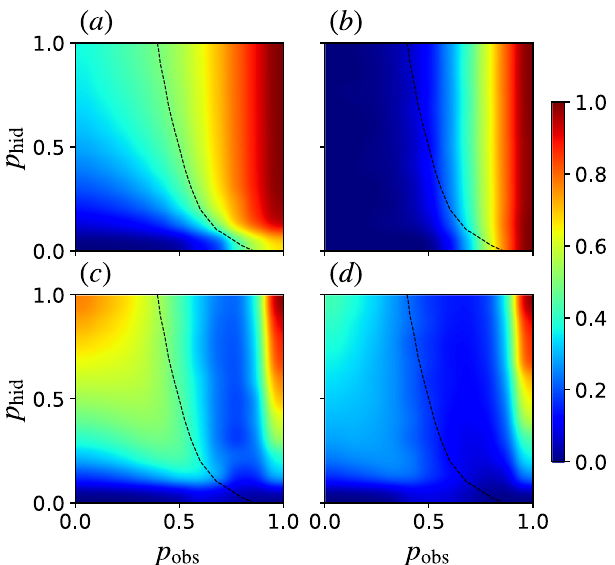
Fig. 4 Properties of the observed network, G O , in the general correlated copying model (GCCM). Numerical results for 10 4 nodes as a function of the hidden/inner copying probability, p hid , and the outer copying probability, p obs . a The effective copying probability. b The densi fi cation exponent. c The average local clustering coef fi cient, CC( G O ). d The transitivity, τ G . Black dashed contour: effective copying probability of 0.5 O at t = 10 4 , calculated numerically. Values have been smoothed for